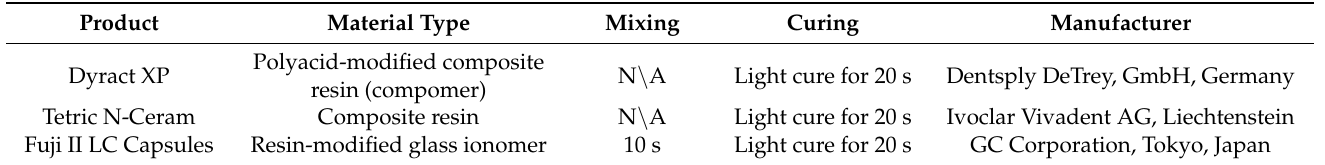
Table 2. Restorative materials used in the